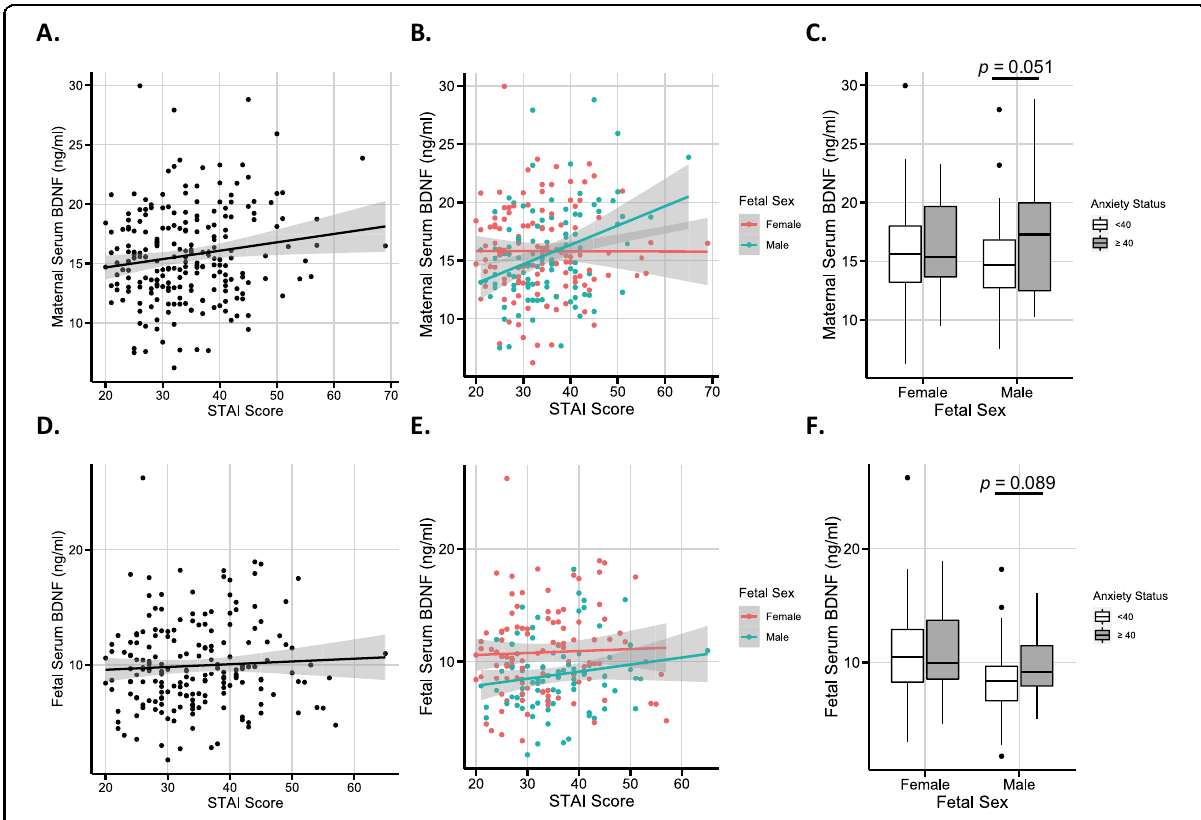
Fig. 3 Maternal serum BDNF values correlate with STAI scores as a measure of anxiety. A , B Maternal serum BDNF values plotted against STAI scores, using ( A ) the whole population ( r = 0.119, P = 0.078, n = 220), and ( B ) split by fetal sex (female: r = − 0.014, P = 0.882, n = 121; male: r = 0.281, P = 0.005, n = 99, Spearman ’ s rank correlation). Using a linear model to control for confounding variables and a mean-centered STAI score, a unit increase in STAI score in mothers of males was associated with a 0.185ng/ml increase in maternal serum BDNF (95% CI: 0.059, 0.309; P = 0.004), whilst there was no effect on maternal serum BDNF from either fetal sex or STAI scores alone ( P = 0.555 and 0.534, respectively). Unadjusted vs. adjusted model shown in Supplementary Table 3. C Comparison of maternal serum BDNF values across anxiety categories and separated by fetal sex ( n : female infants, STAI < 40: 92, ≥ 40: 29; male infants, STAI < 40: 68, ≥ 40: 31). D , E Fetal serum BDNF values plotted against STAI scores, using ( D ) the whole population ( r = 0.056, P = 0.437, n = 192), and ( E ) split by fetal sex (female: r = 0.073, P = 0.458, n = 105; male: r = 0.131, P = 0.226, n = 87, Spearman ’ s rank correlation). F Comparison of fetal serum BDNF values across anxiety categories and separated by fetal sex ( n : female infants, STAI < 40: 79; ≥ 40: 26; male infants, STAI < 40: 62; ≥ 40: 25). STAI: Spielberger State-Trait Anxiety Inventory. 95% con fi dence intervals are shaded in gray. Boxplot values indicate the following: Box boundaries, 25% and 75% quartiles; mid-line, median; whiskers, highest and lowest values within 1.5 × IQR of the box boundary; outliers, values outside the